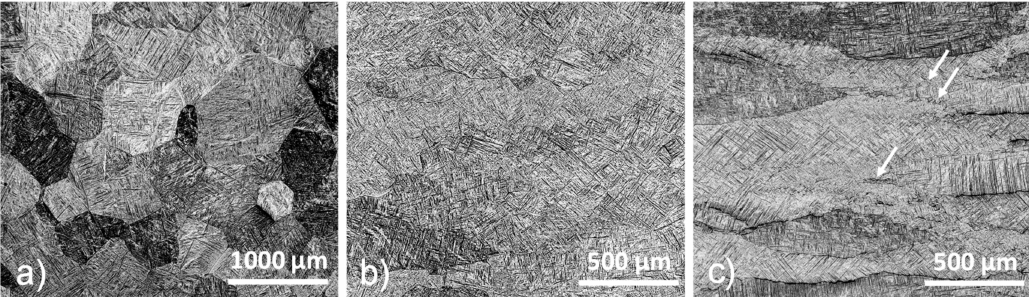
Figure 2. LOM images of samples heat treated at 1030 ◦ C with the Gleeble ® 1500 machine and ( a ) soaked during 10 min, and ( b , c ) deformed at a strain rate of 0.001 and 0.1 s − 1 , respectively. Serrated grain boundaries are observed in both cases. Load axis is vertical.